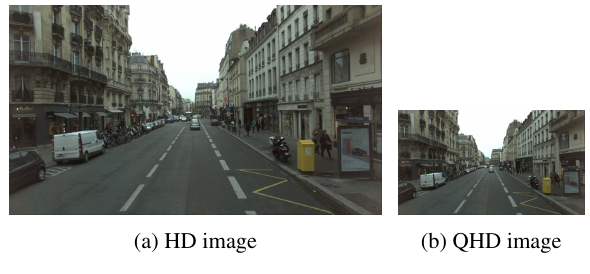
Figure 5. HD and QHD